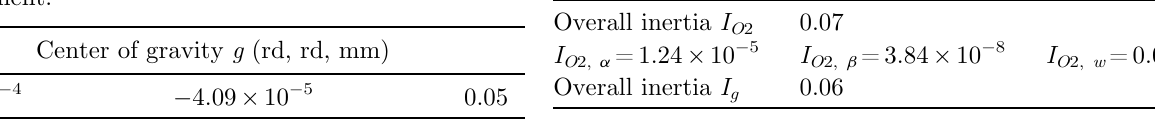
Table 3. Components of inertia of noise of